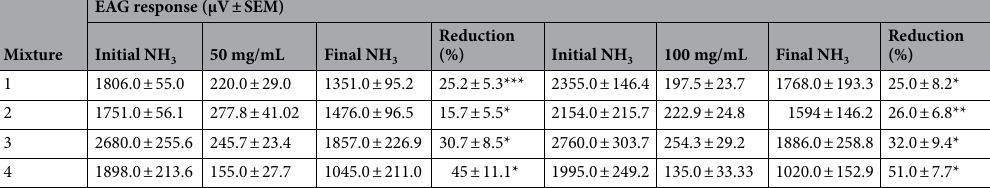
Table 2. Electroantennography signals (microvolts ± standard deviation, µV ± SEM) regarding the mixtures 1, 2, 3, 4 in the 50 and 100 mg/mL concentrations using a single mosquito per replicate and concentration. In each experiment, an initial and final stimulus of ammonia was applied. Besides, in each concentration, it is shown the percentage reduction concerning the ammonia signal obtained after applying the mixtures mentioned. Mixture 1 (geranyl acetate, α-bisabolol, and nerolidol), mixture 2 (geranyl acetate and nerolidol), mixture 3 (nerolidol and α-bisabolol), mixture 4 (geranyl acetate and α-bisabolol). (*), (**), and (***) indicate differences statistically significant between EAG pre- and post-treatment ammonia signals. One way ANOVA, (*) p < 0.05; (**) p < 0.01; (***) p < 0.001, post hoc Tukey